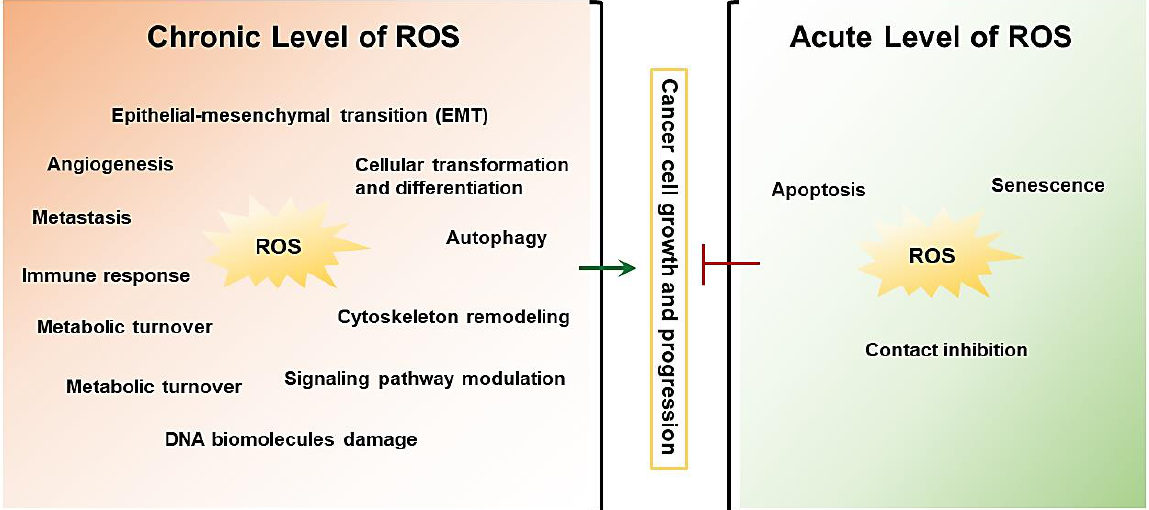
Figure 2. Two different edges of ROS in various biological pathways. ROS at chronic and acute levels can promote several pathways. In normal cells, a high level of ROS can create oxidative conditions and damage cells. This event is the basis for the occurrence of various mutations and the creation of cancerous cells. In cancer cells, acute levels of ROS can create unfavorable conditions and conduct cancer cells to apoptosis and death.